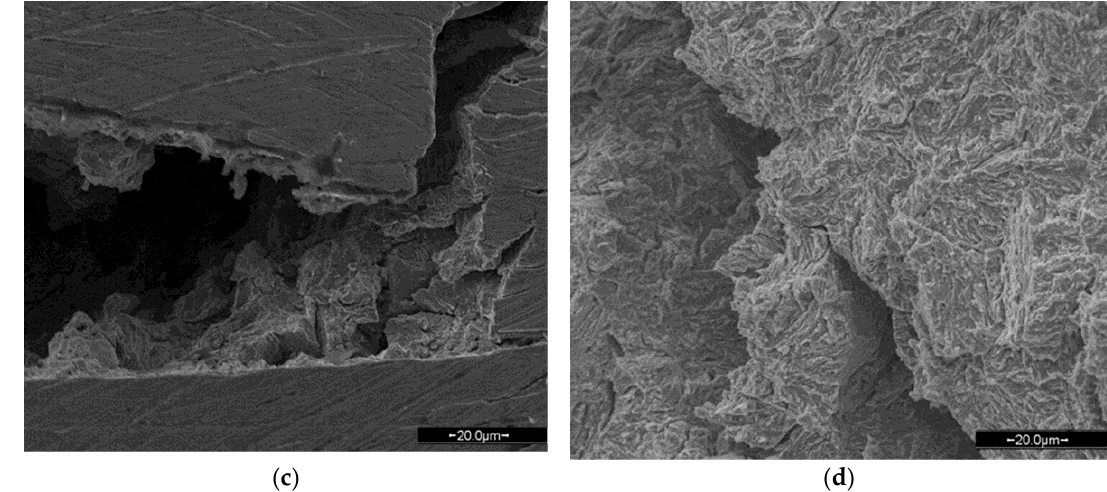
Figure 5. ( a ) SEM fracture surface of SSR sample tested in H 2. ( b ) Lateral Image of SEM fracture surface of SSR sample tested in H 2. ( c ) Secondary crack image of SEM fracture surface of SSR sample tested in H 2. ( d ) Surface of the crack of SEM fracture surface of SSR sample tested in H 2. From the micrographs of Figure 5c,d, a mainly brittle fracture surface is visible.